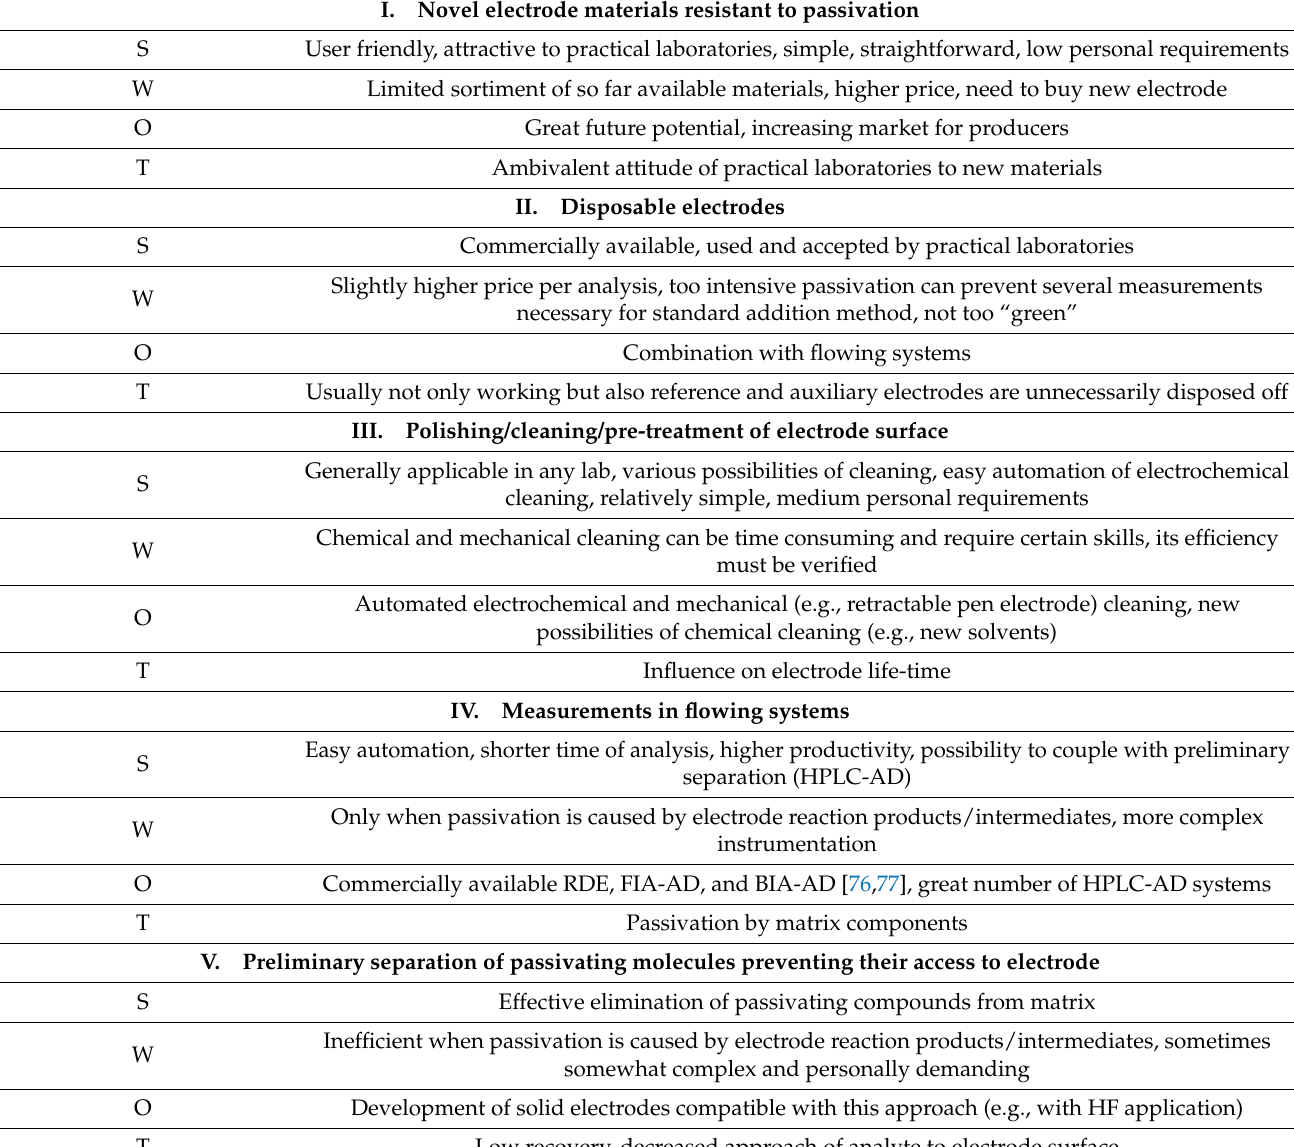
Table 1. SWOT analysis of different approaches to the minimization of electrode